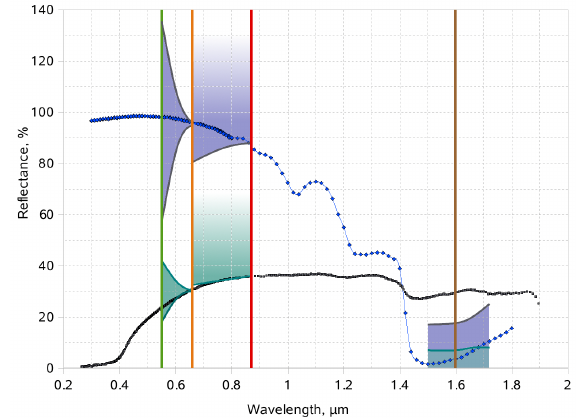
Fig. 4. The allowed amount of TOA reflectance scatter is shown Figure 4. The allowed amount of TOA reflectance scatter is shown for fresh dry snow (blue 3 for fresh dry snow (blue curve) and dry long grass (black curve). curve) and dry long grass (black curve). Violet and turquoise areas are the schematic view of 4 Violet and turquoise areas are the schematic view of the spectral the spectral shape criterion. They show where the corresponding spectral curve should go to 5 shape criterion. They show where the corresponding spectral curve be still recognized as snow. It is visible that dry long grass spectrum does not satisfy the 6 should go to still be recognized as snow. It is visible that dry long spectral shape criterion, e.g. at channel 1.6µm. 7 grass spectrum does not satisfy the spectral shape criterion, e.g. at channel